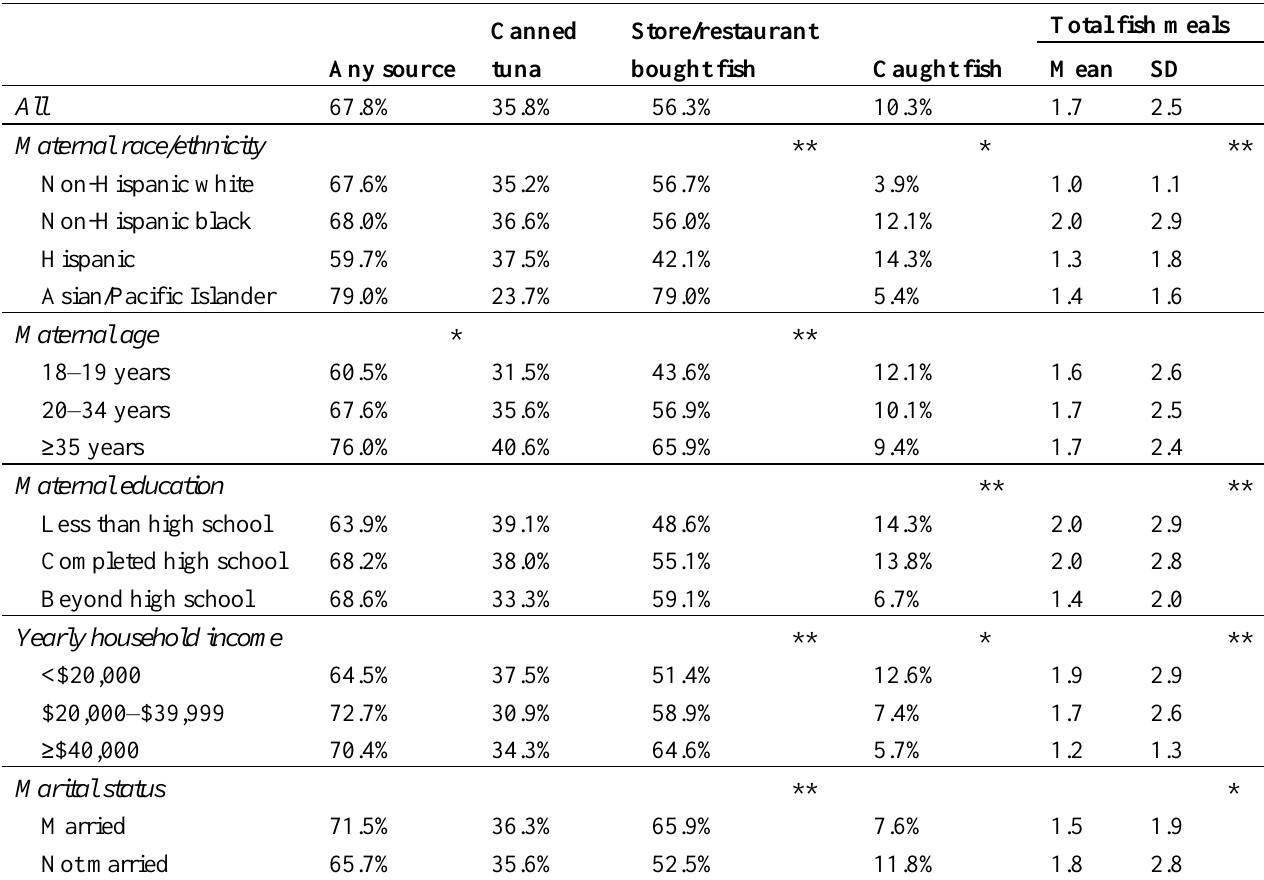
Table 2. Percent reporting fish consumption from various sources (among those answering each survey question) and mean total reported fish meals per week by demographic and socioeconomic